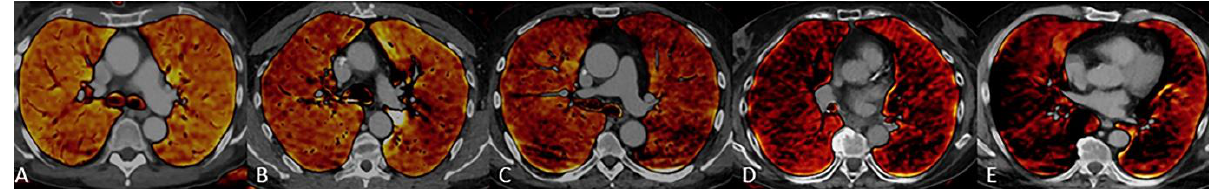
Figure 3. Examples for subjective overall diagnostic image quality of the perfusion blood volume (PBV) images: ( A ) excellent (Likert 1), ( B ) good (2), ( C ) adequate (3), ( D ) deficient (4), ( E ) poor (5). All images are displayed in the same window (width 80 HU, center 40 HU).